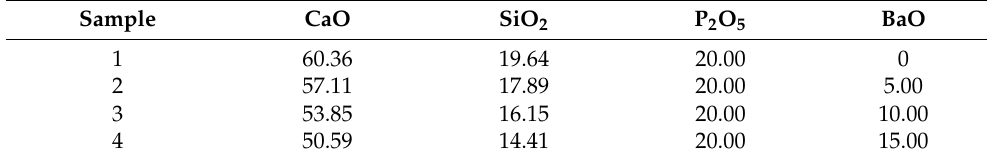
Table 3. Chemical compositions of solid solutions with different BaO content (wt.%).